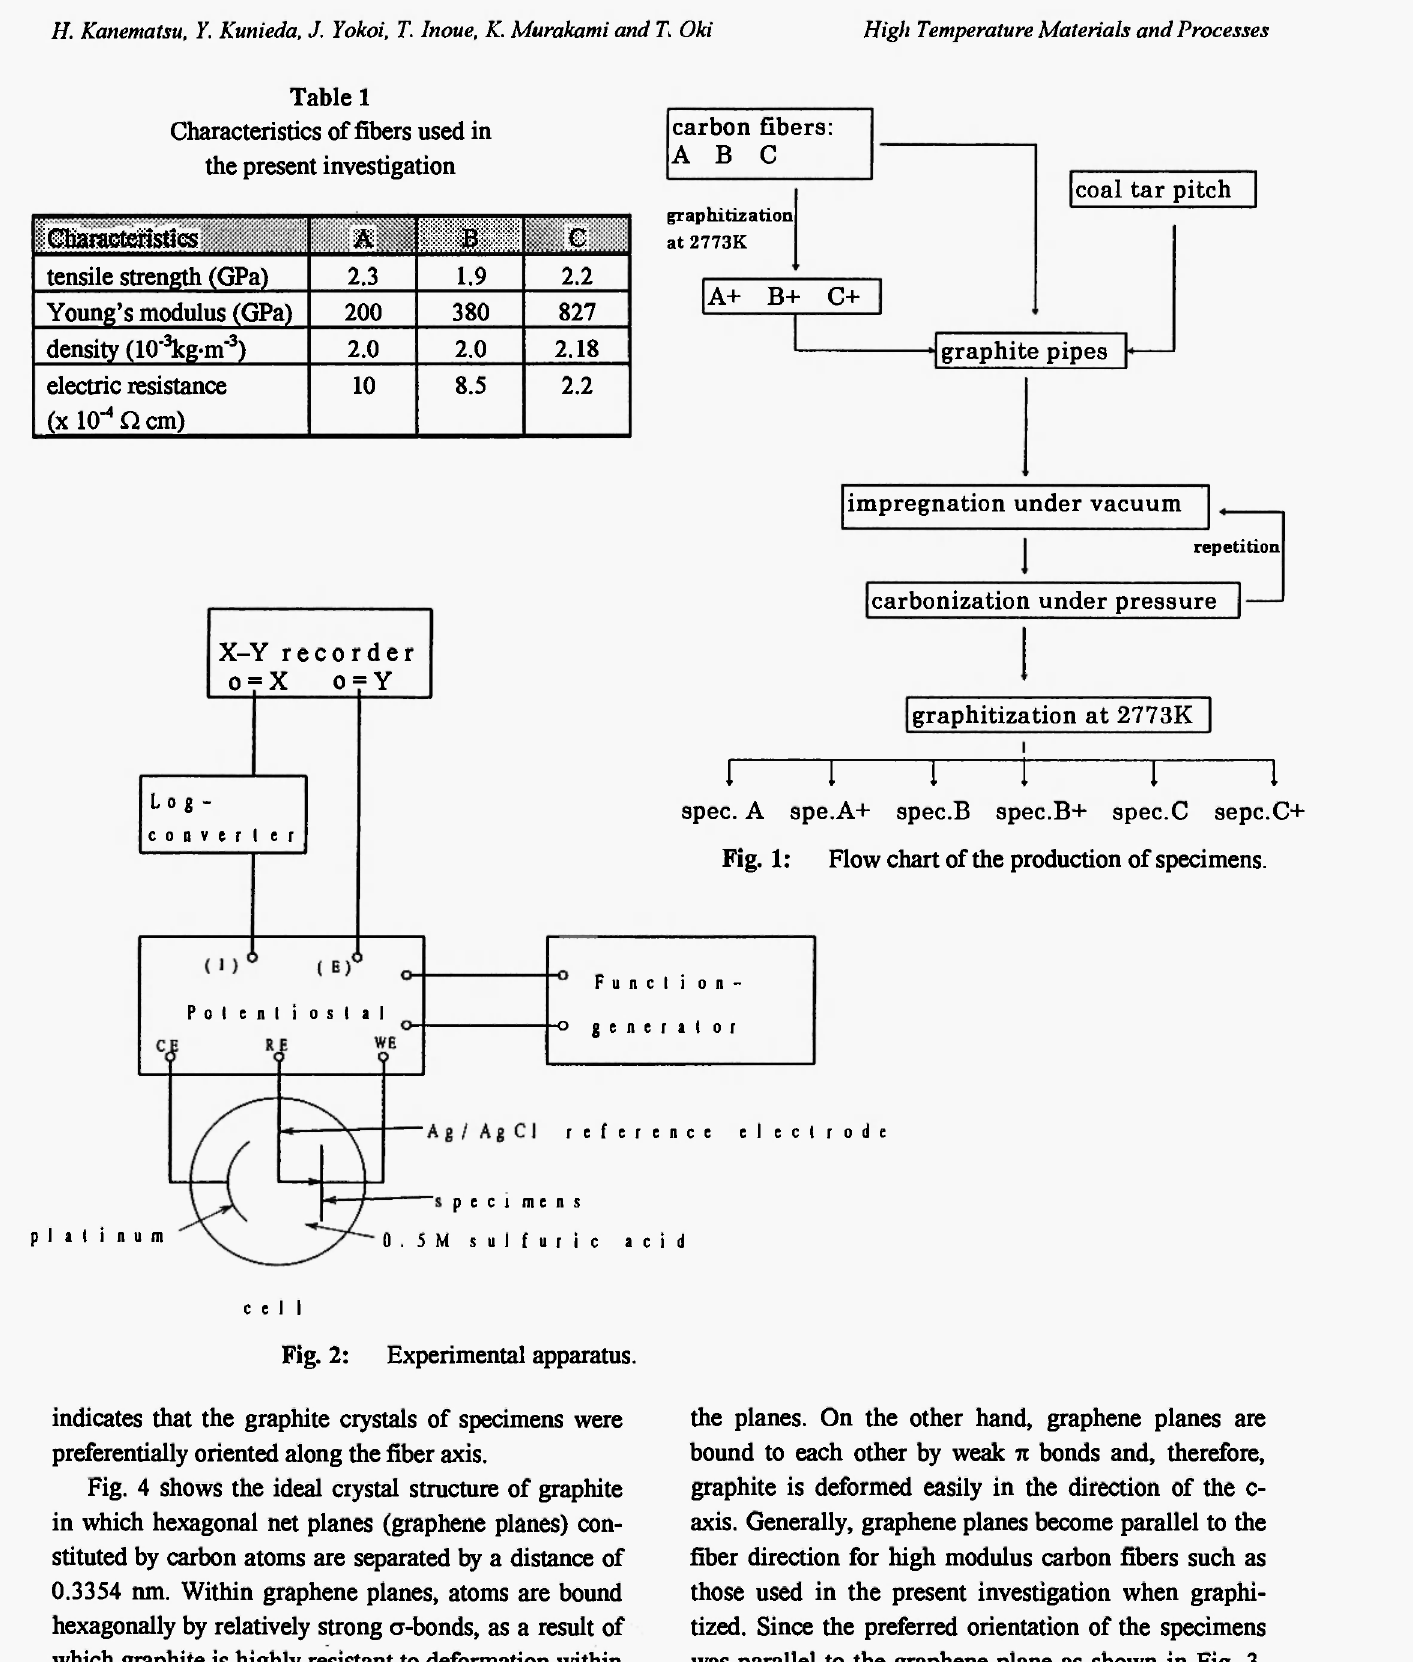
Fig. 2: Experimental